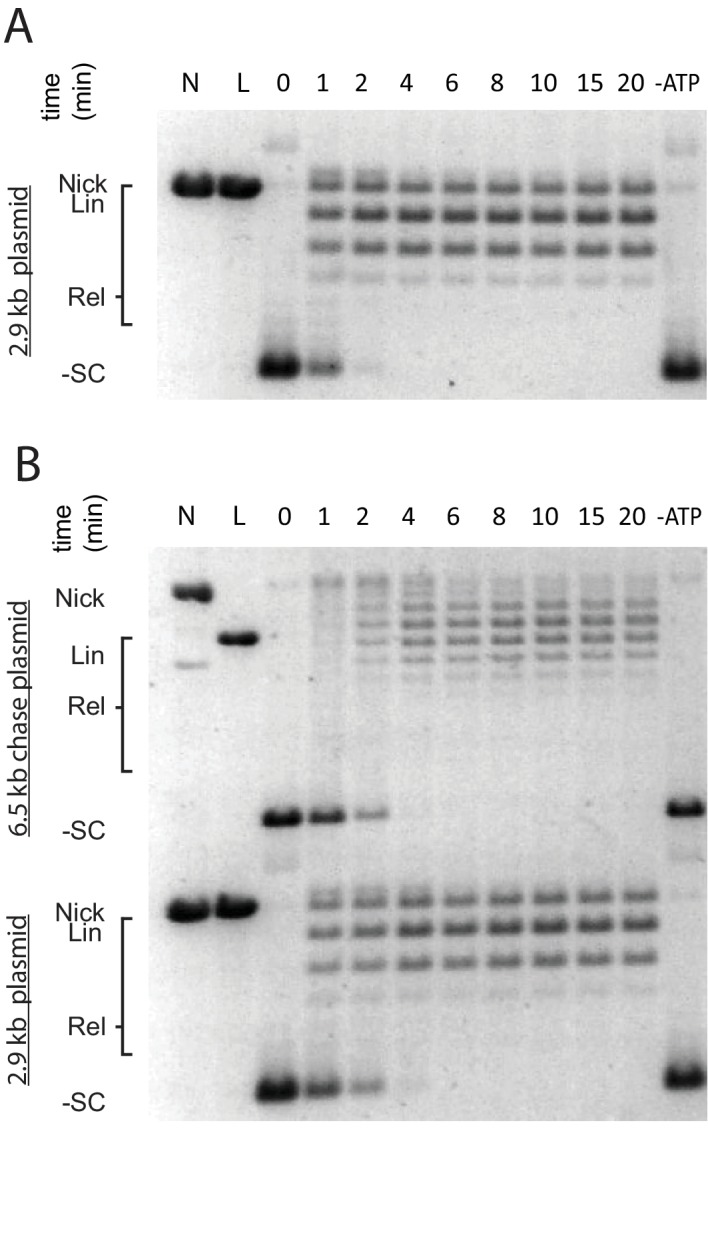
Topo II processively relaxes supercoiled DNA as compared to topo VI.An example of processive supercoil relaxation by ScTop2ΔCTR, as compared to topo VI in Figure 1C–D. ScTop2ΔCTR was pre-incubated in a 1:1.4 ratio to a 2.9 kb negatively supercoiled plasmid (6.7 ng/uL in assay). Reactions were started by addition of either (A) ATP or (B) ATP and a 6.5 kb ‘chase’ plasmid (6.7 ng/uL in assay) to compete for unbound enzyme. Samples were quenched at 0, 1, 2, 4, 6, 8, 10, 15, and 20 min. Each condition was also incubated without ATP for 20 min as a negative control. Topoisomer species and identification of each plasmid are indicated on the left of each gel.